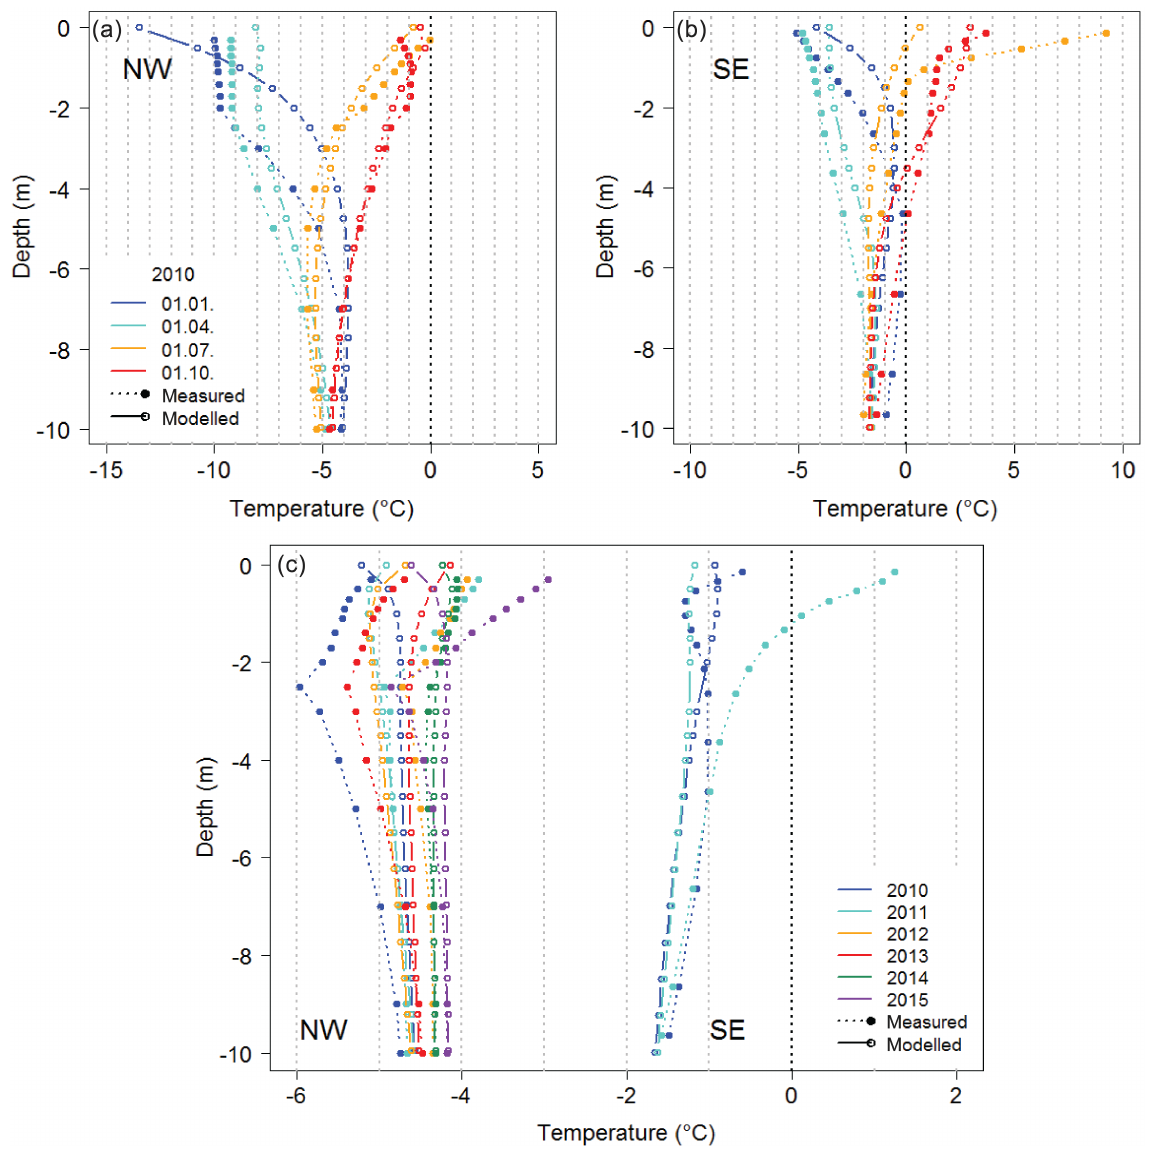
Figure 6. Evaluation of modelled bedrock temperature against measured bedrock temperature in the AdM NW and SE boreholes at daily time step (a, b) and annual time step (c)